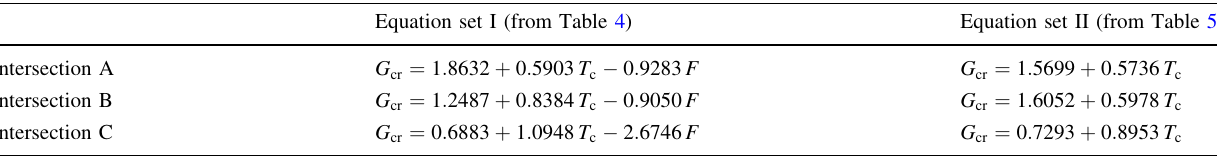
Table 8 Equation sets for estimating critical gap Equation set I (from Table 4) Equation set II (from Table 5